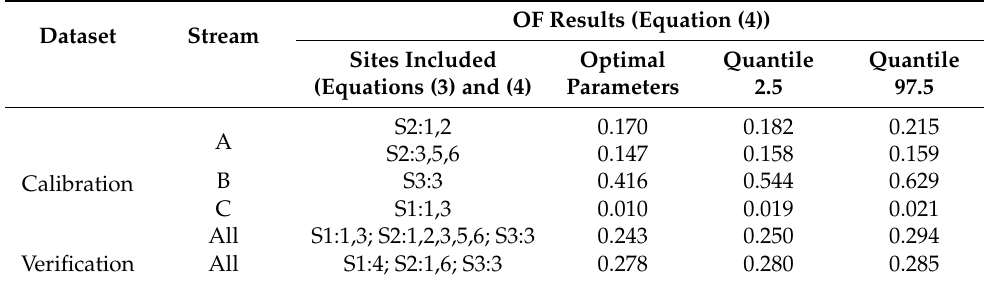
Table 6. Model performance with calibration and verification datasets.